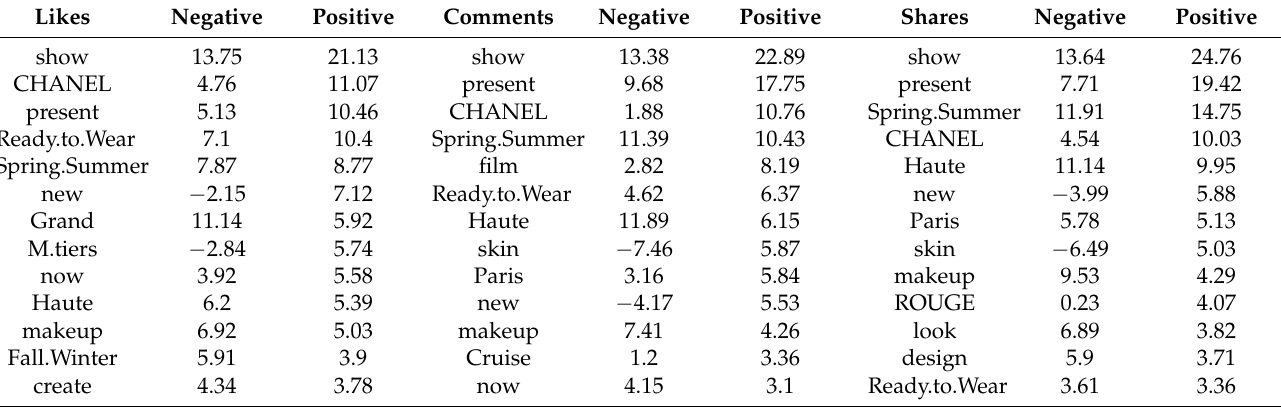
Table A3. Negative and positive cues for